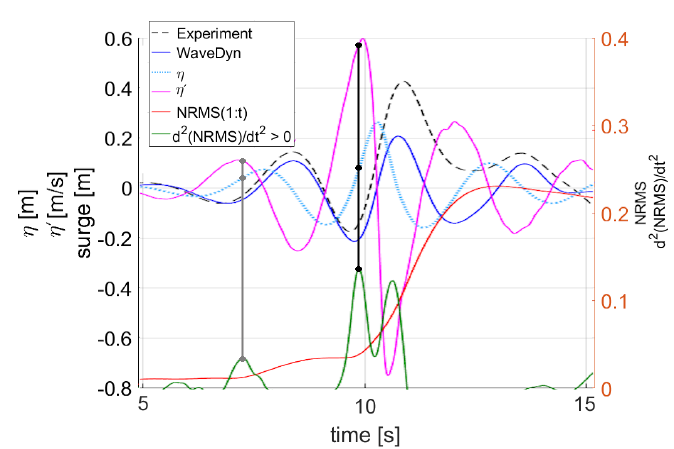
Figure 10. Identification of wave-parameters at deviation point for ST 1. | is the deviation point, | is the second largest peak (i.e., a non-deviating point).